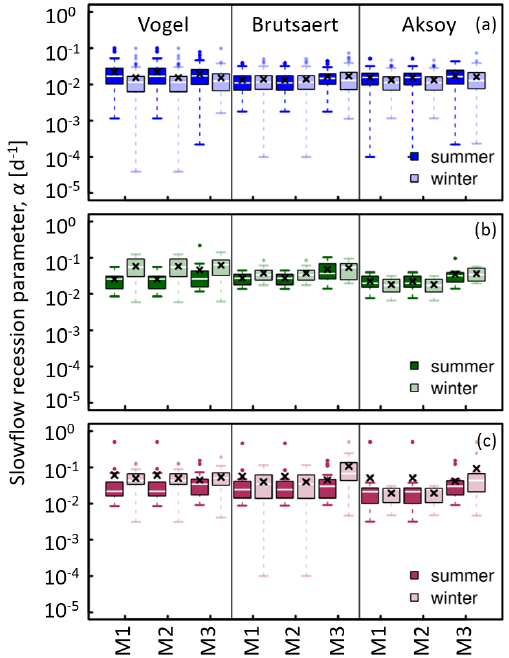
Figure 4. Distribution and variability of the slow-flow recession parameter, α , obtained by the combination of REM (Vogel, Brut- saert, and Aksoy) and POA (M1, M2, and M3) for summer and winter periods: (a) Lehnbachquellen spring in the snow-dominated catchment, (b) Saivu spring located in the humid catchment, and (c) Qachquoch spring in the Mediterranean catchment. The box- plots represent the interquartile range, whisker lines correspond to the most extreme parameter values, and outliers are marked as cir- cles with corresponding box